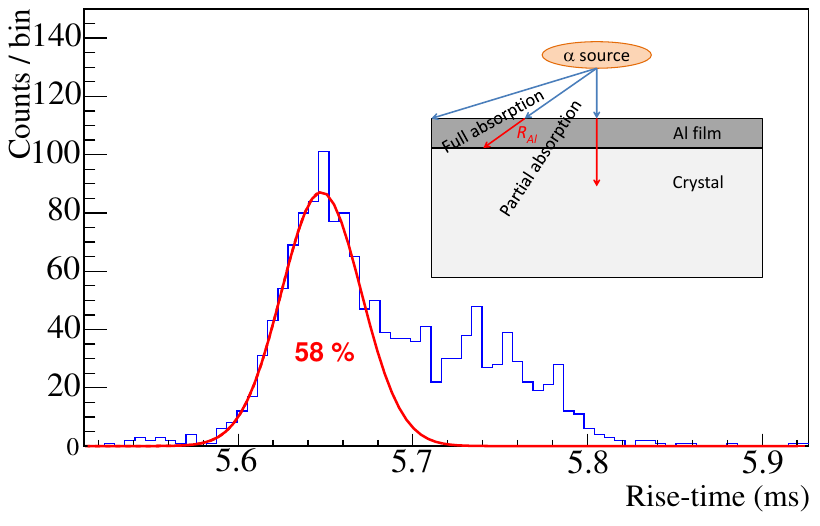
Figure 6 . Rise-time distribution of signals corresponding to the (cid:24) 4 : 2 MeV (cid:11) -particle from the uranium source. The fraction of (cid:11) particles that deposit their full energy in the 10 (cid:22) m thick Al (cid:12)lm coating the Li 2 MoO 4 crystal is (cid:24) 58%, in agreement with a Monte Carlo simulation. In the inset, schematic geometry of the (cid:11) -particle absorption at the (cid:12)lm-coated side of the crystal. R Al represents the range of (cid:11) particles in aluminum.